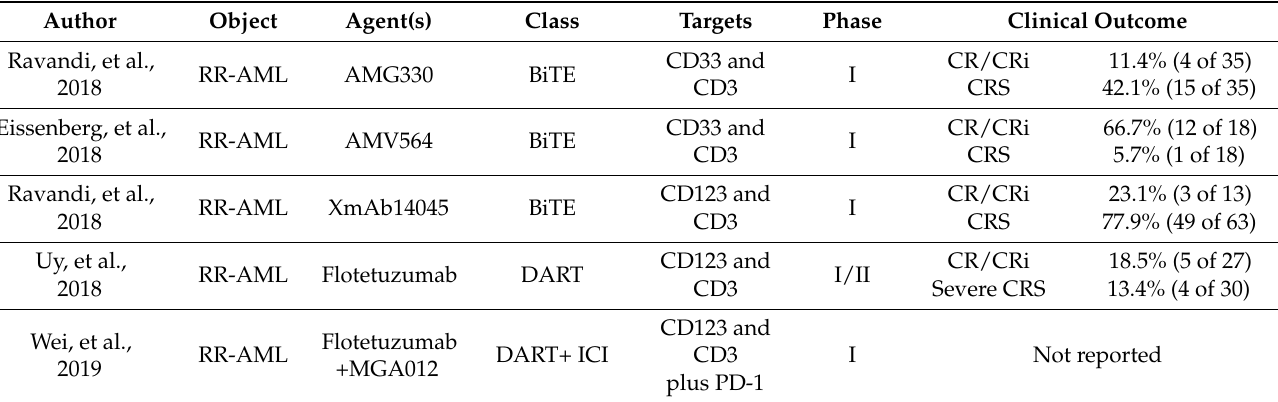
Table 3. A summary of clinical trials of bispecific antibodies for relapsed/refractory AML (RR-AML). BiTE: bispecific T-cell engager, DART: dual-affinity retargeting molecule, ICI: immune checkpoint inhibitor, CR: complete remission, CRi: CR with incomplete hematologic recovery, CRS: cytokine releasing